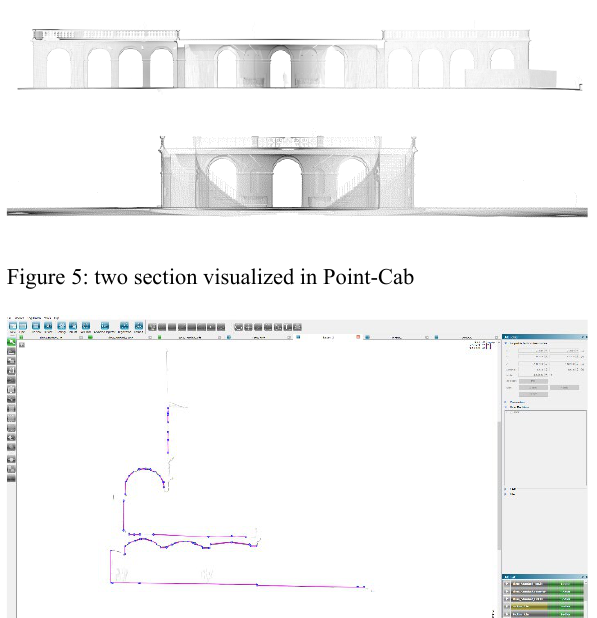
Figure 6: a vector section visualized in Point-Cab When imported the point cloud in the .e57 file (but the .xyz format is also available) it matches with the previously embedded views.